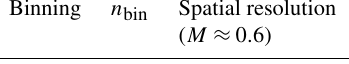
Table A1. Spatial resolution and binning factor dependent on pixel binning. Binning